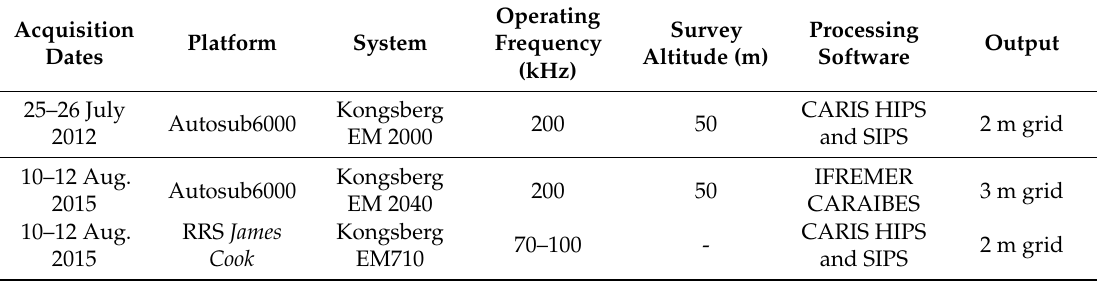
Table 2. Multibeam echosounder bathymetry acquisition